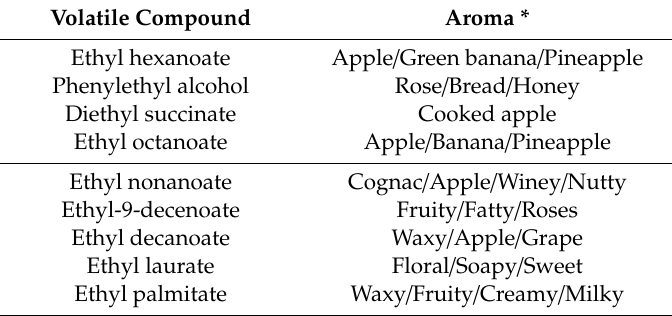
Table 2. Volatile compounds identified using gas chromatography–mass spectroscopy and their associated aromas.